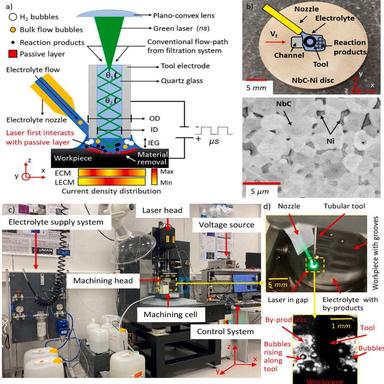
Process schemes and experimentations. a) ECM and LECM process schematic with side electrolyte flow. b) NbC–Ni cermet sample and processing methodology, with microstructure showing NbC phase (bright) and Ni phase (dark). c) In-house developed hybrid laser-ECM setup. d) Close-up of channel machining with LECM on NbC–Ni cermet and gap observations with high speed camera.